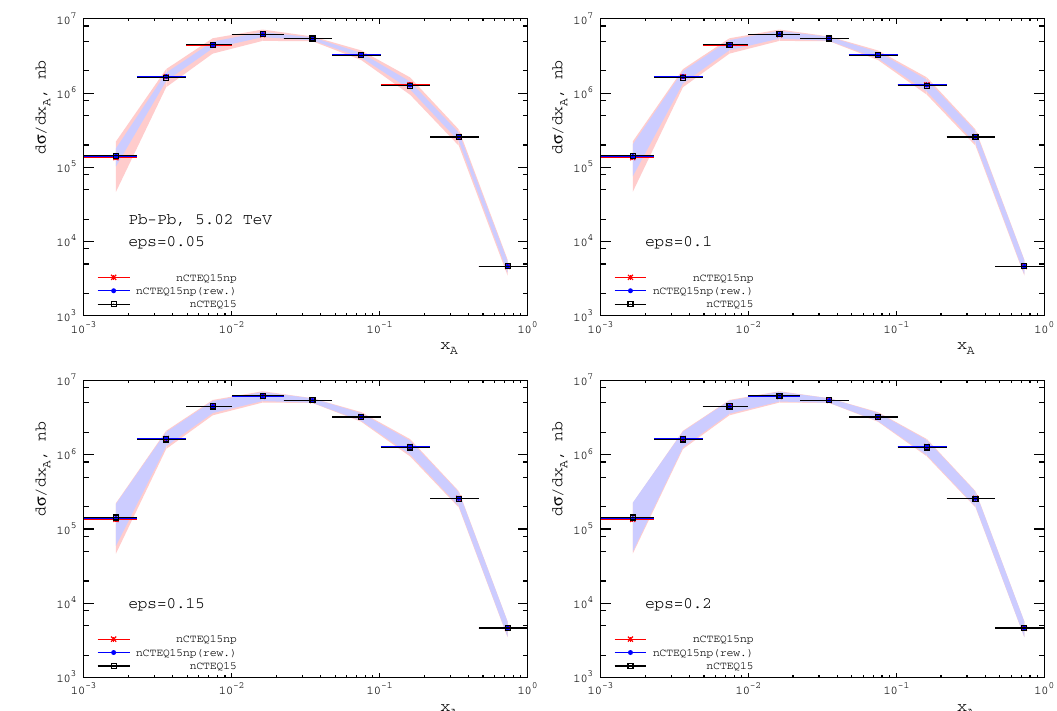
Fig. 5 The dijet photoproduction cross section as a function of x A with (blue solid circles and error bands) and without (red crosses and errorbands)theBayesianreweightingcalculatedusingthenCTEQ15np